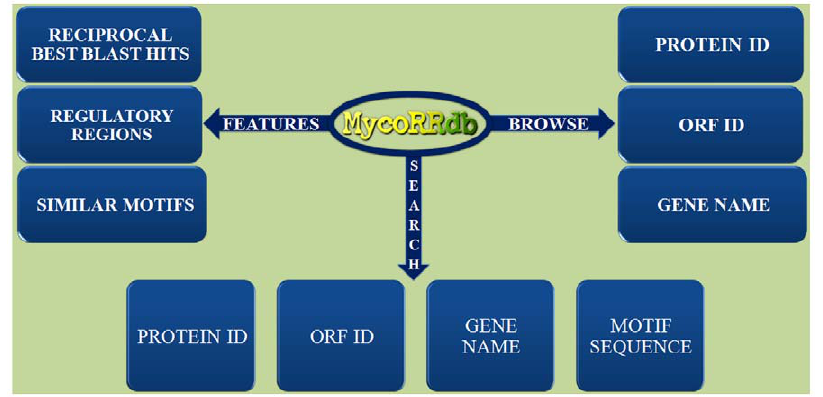
Figure 2. Schematic architecture of MycoRRdb.